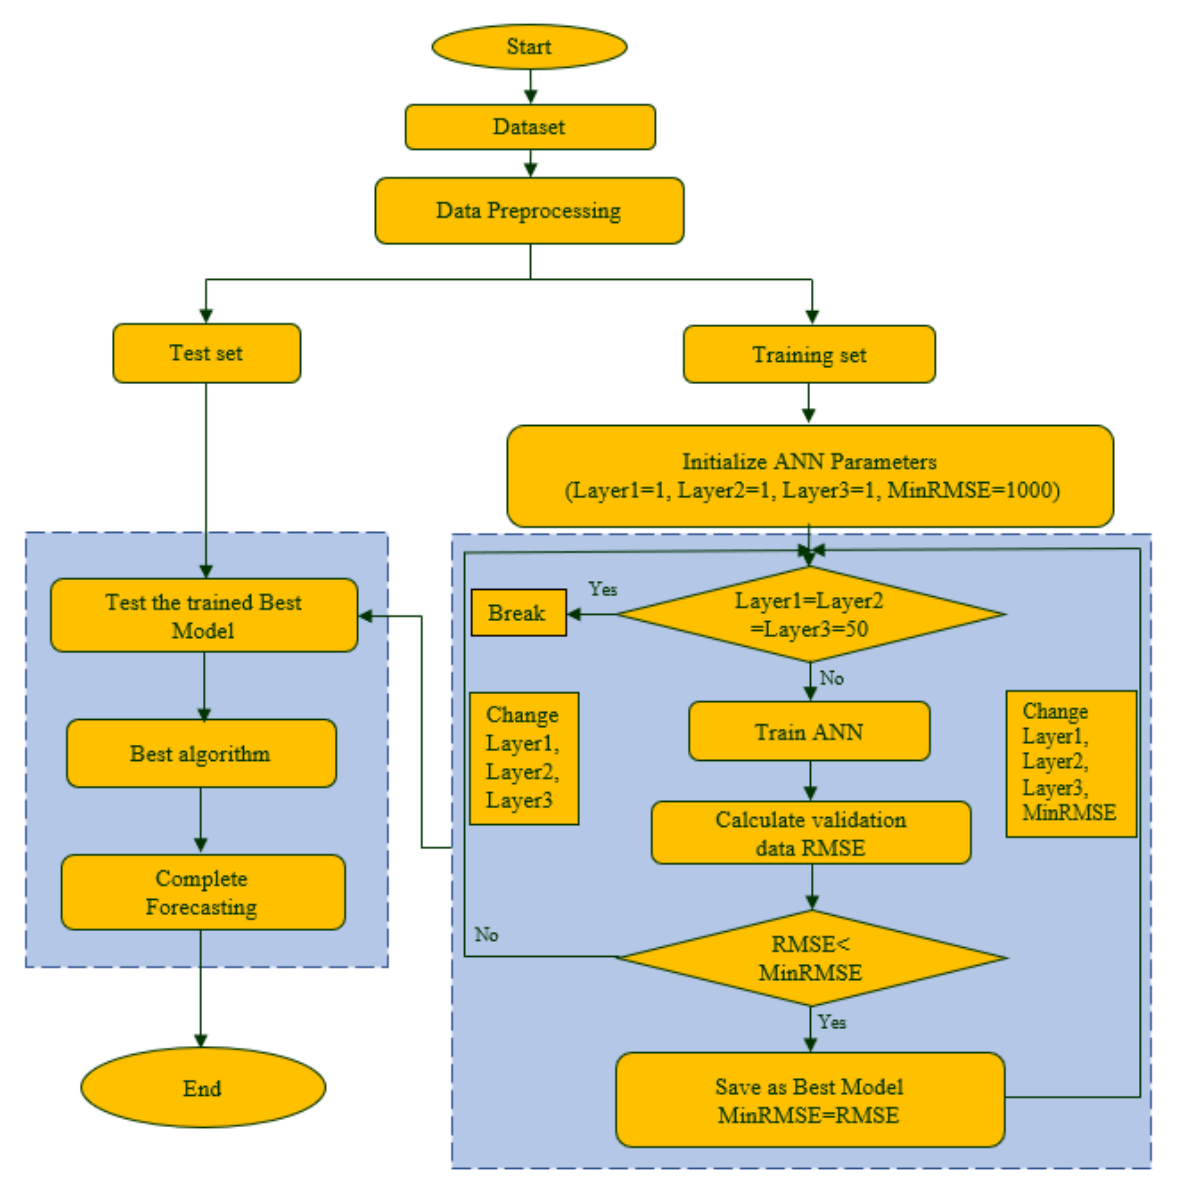
Figure 4. The execution procedures of the ANNs model.